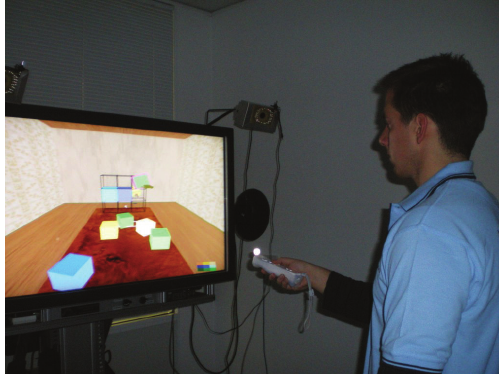
Figure 5: The experimental platform.